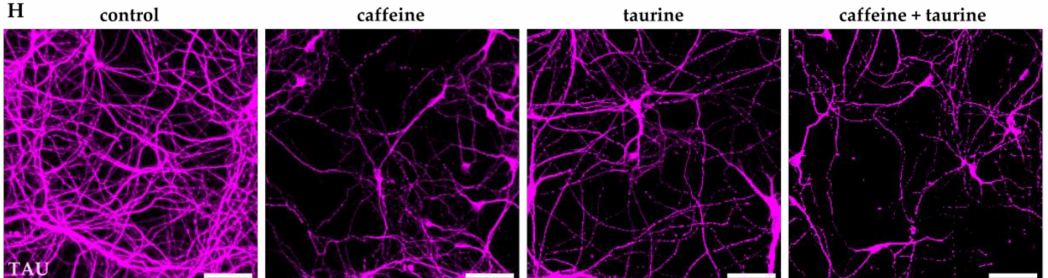
Figure 5. Ca ff eine and taurine lead to sustained reduced dendritic branching and disturbed axonal network formation. After three days in culture primary hippocampal neurons were treated with or without 0.3 mg / mL ca ff eine, 4 mg / mL taurine and the combination of both for 24 h followed by cultivation under standard culture conditions for another three days. ( A ) Representative images of Map2 (green) stained dendrites. Quantifications of the amount of total, primary and higher dendrites, as well as their lengths are shown in subfigures ( B – G ). Data are derived from 25–30 images per group out of three independent experiments (n = 75–82 cells per group, depicted by circle = control, square = ca ff eine, triangle up = taurine, triangle down = ca ff eine + taurine). Morphological changes of axons were visualized by immunofluorescence staining for TAU ( H ). Scale bar 100 µ m. *** p < 0.001,